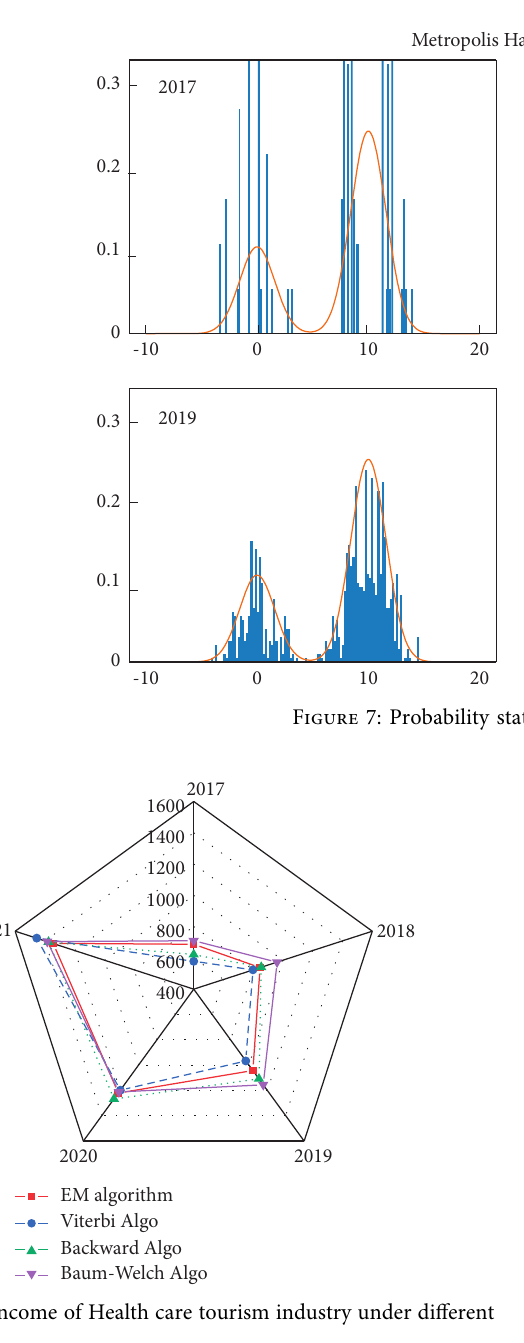
Figure 8: Income of Health care tourism industry under different algorithms.